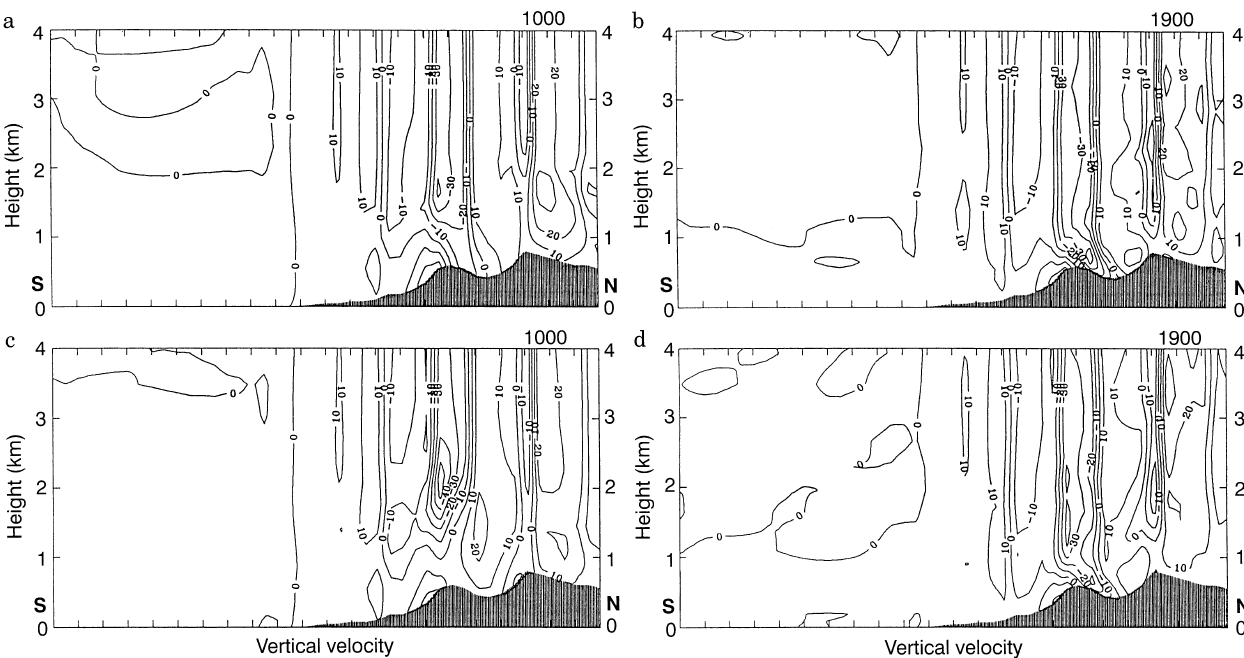
Fig. 4a–d. Vertical cross sections of vertical wind speed in cm/s at a 1000 LST, E1; b 1900 LST, E1; c 1000 LST, E2; d 1900 LST, E2